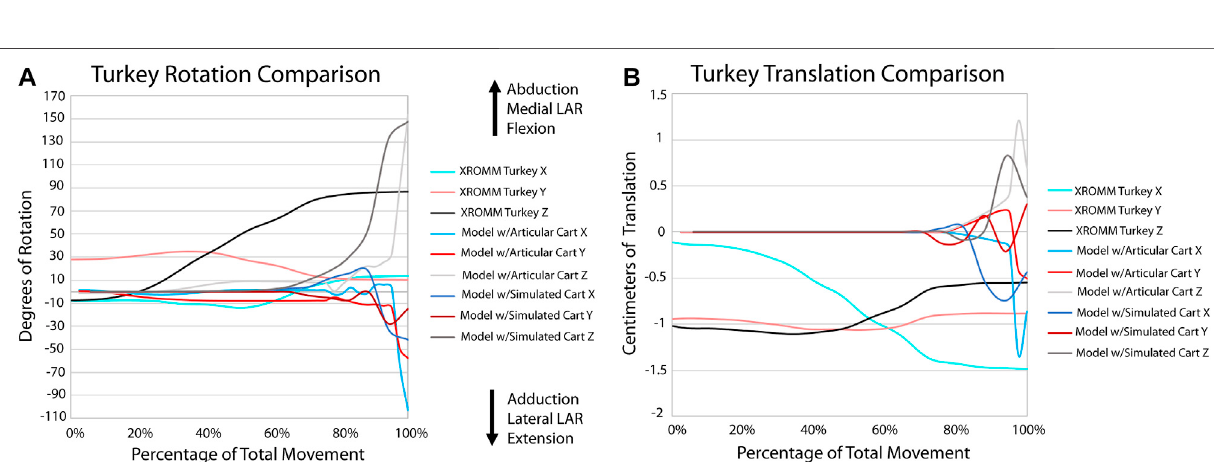
Frontiers in Earth Science |